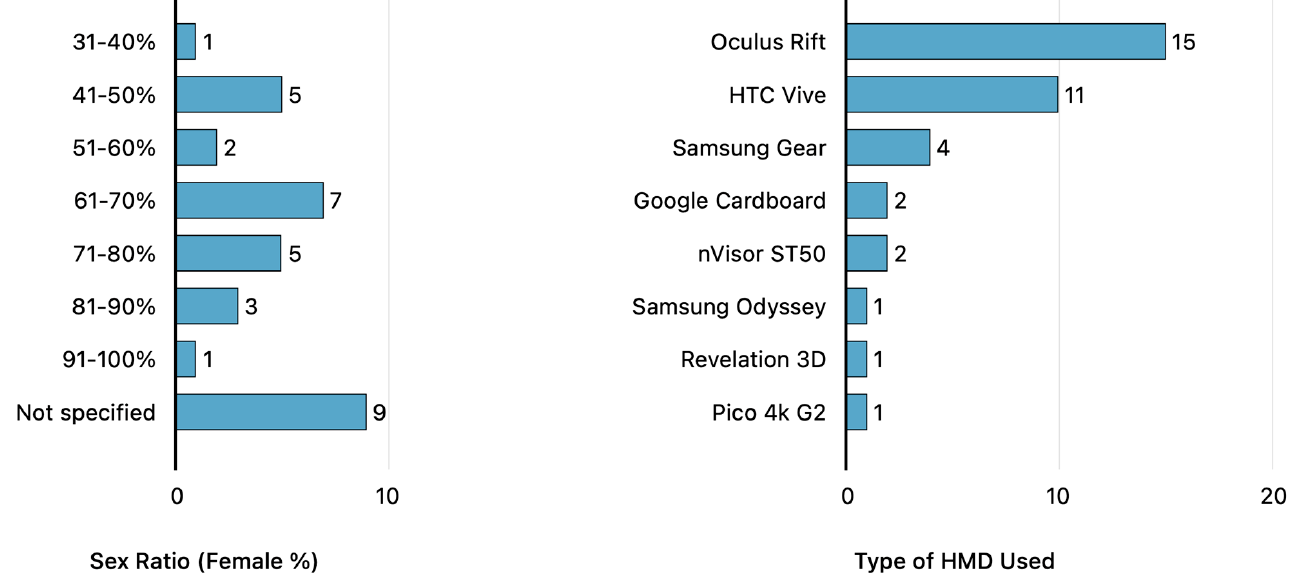
Figure 3. Studies classified based on sex ratio in sample size ( a ) and HMD type ( b